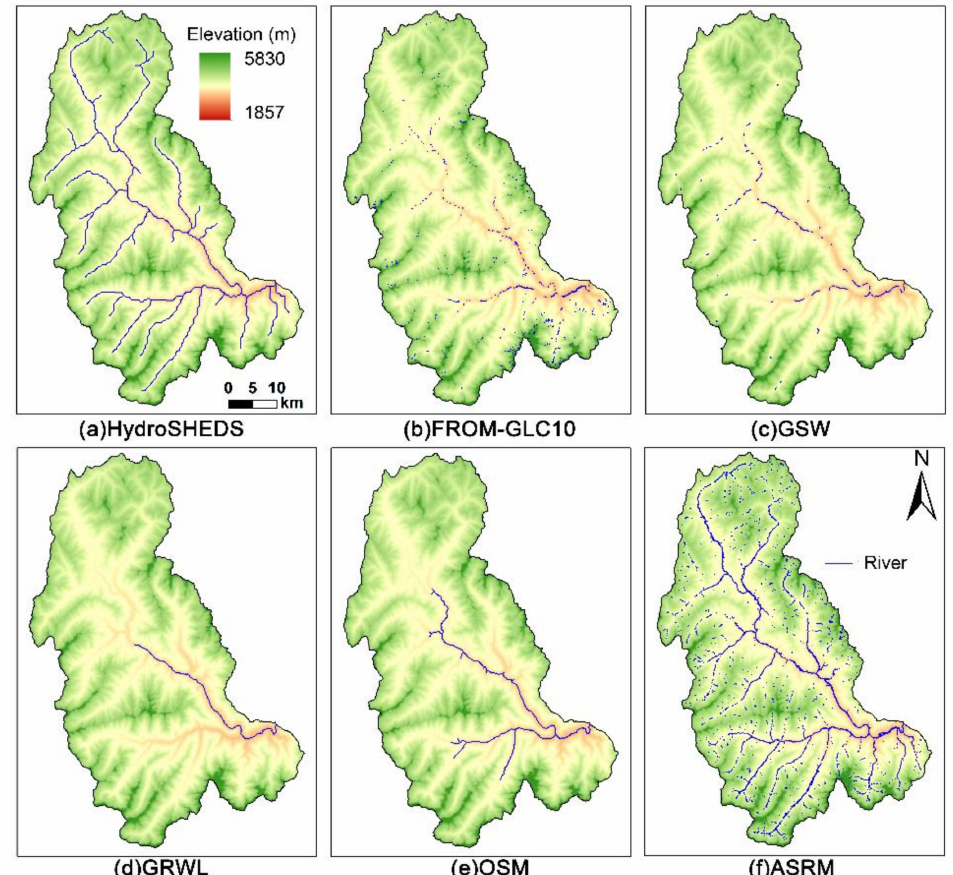
Figure 11. Comparison of ASRM with other remote sensing data